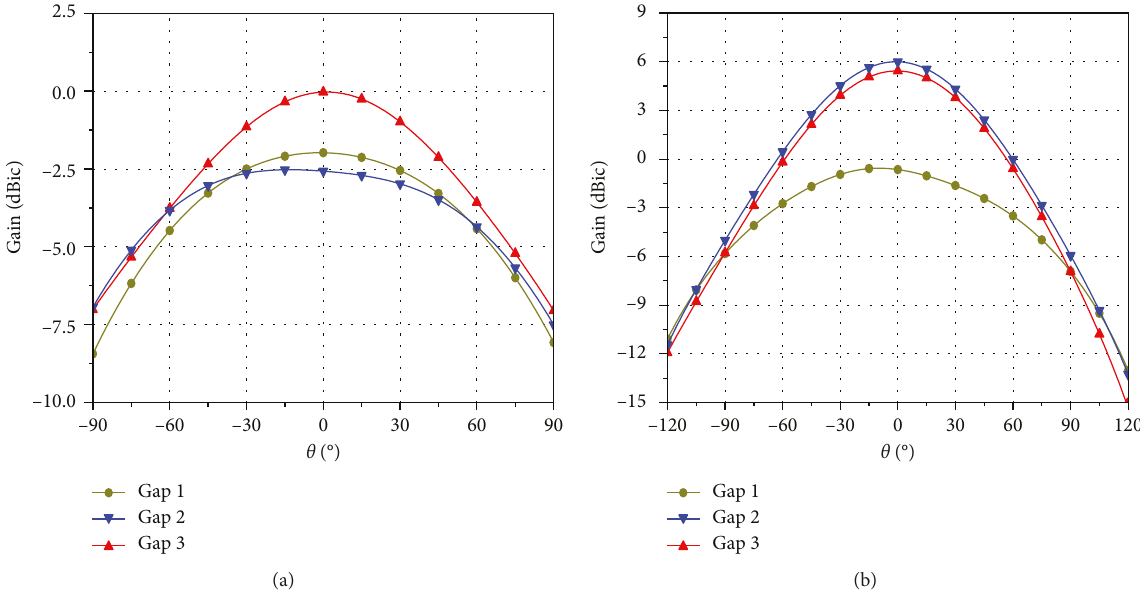
Figure 8: Radiation patterns for different locations of the gaps on the D-APMS. (a) 1.207GHz. (b) 1.561GHz.